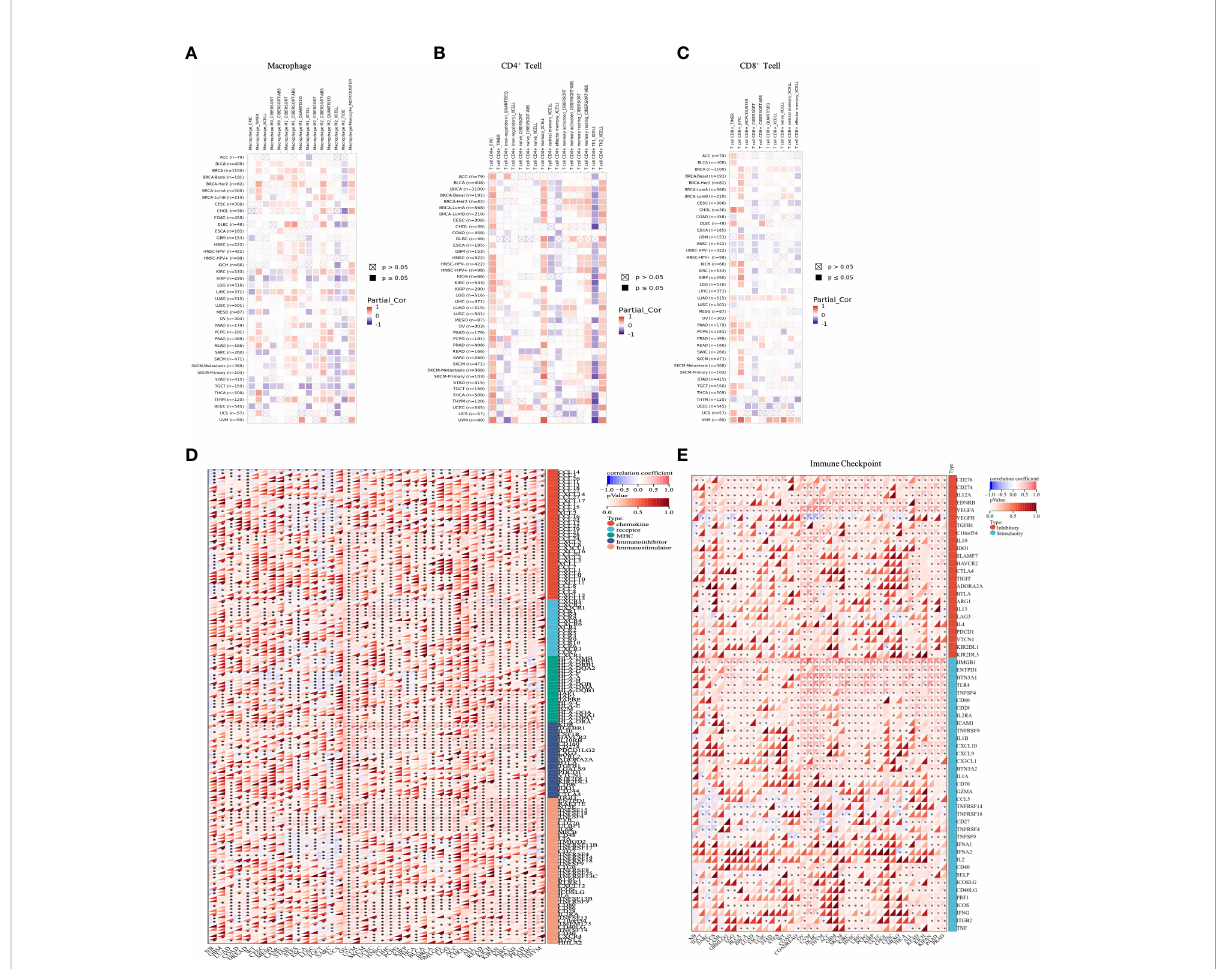
FIGURE 7 Analysis of different immune cell in fi ltrations. (A) Correlation between OTUD6B expression and macrophage, from the TIMER2 database. (B) Correlation between OTUD6B expression and CD4 + T cells from the TIMER2 database. (C) Correlation between OTUD6B expression and CD8 + T cells from the TIMER2 database. (D) The heatmap reveals the correlation between immune-related gene expression such as chemokine genes, chemokine receptor genes, MHC, immunostimulatory genes, and immunoinhibitory renes. (E) Immune-checkpoint related genes. (*p < 0.05; **p < 0.01; ***p < 0.001 and ****p <